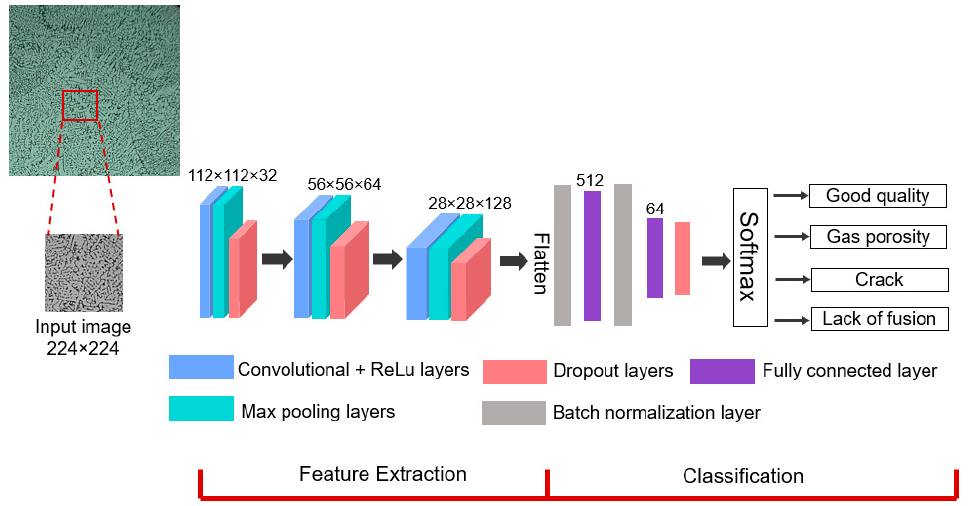
Figure 3. Final schematic of the convolutional neural network (CNN) model for autonomous recognition of LMD build parts quality.